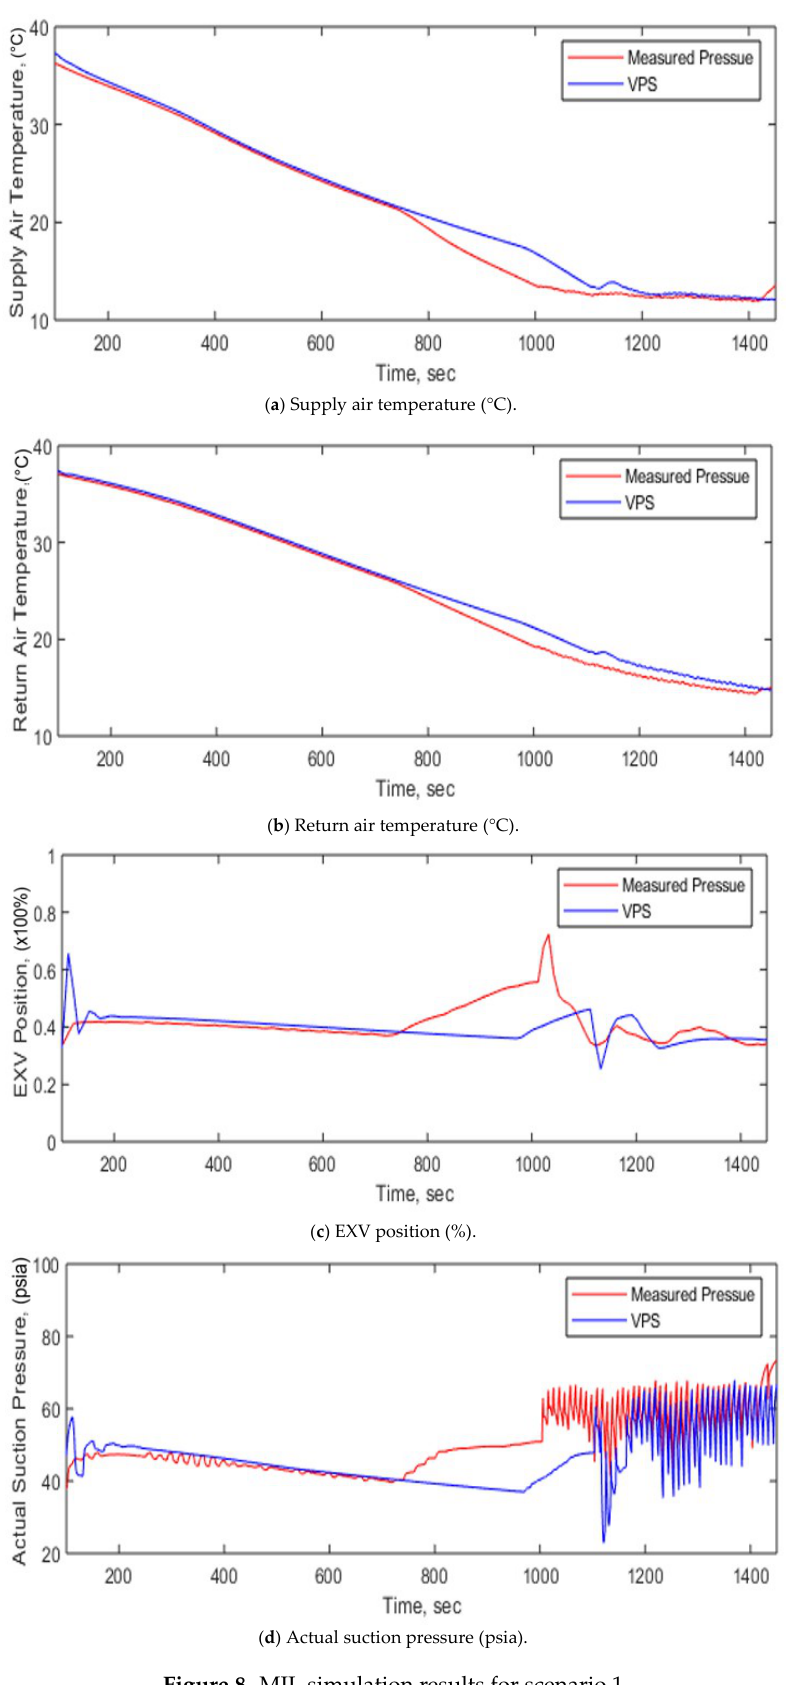
Figure 8. MIL simulation results for scenario 1.